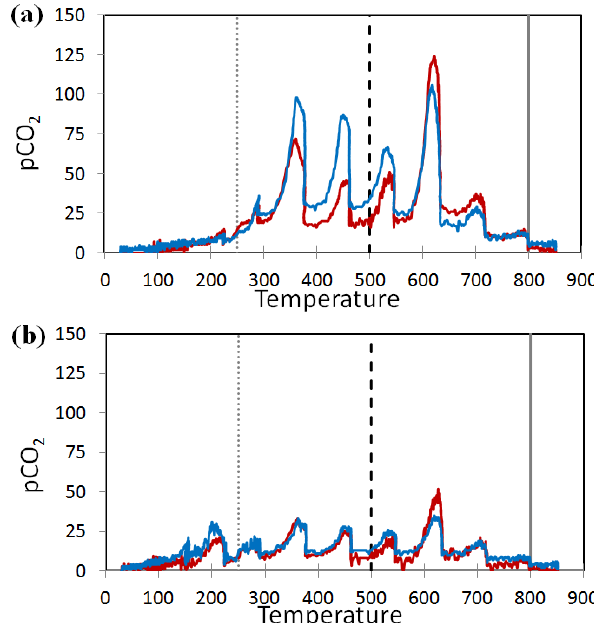
Figure 6. Thermograms ( n = 2; blue and red lines) of phytoliths obtained from (a) durum wheat leaves, phytoliths extracted follow- ing protocol 1a (Table S2), and (b) soil phytoliths MSG70 extracted using a conventional protocol adapted to soil and sediment materi- als. Peaks are artifacts of the 100 ◦ C temperature-step increments. Vertical lines indicate main temperature thresholds, as explained in the